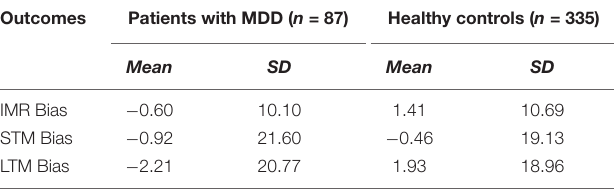
TABLE 5 | Descriptive information for VAMT biases.